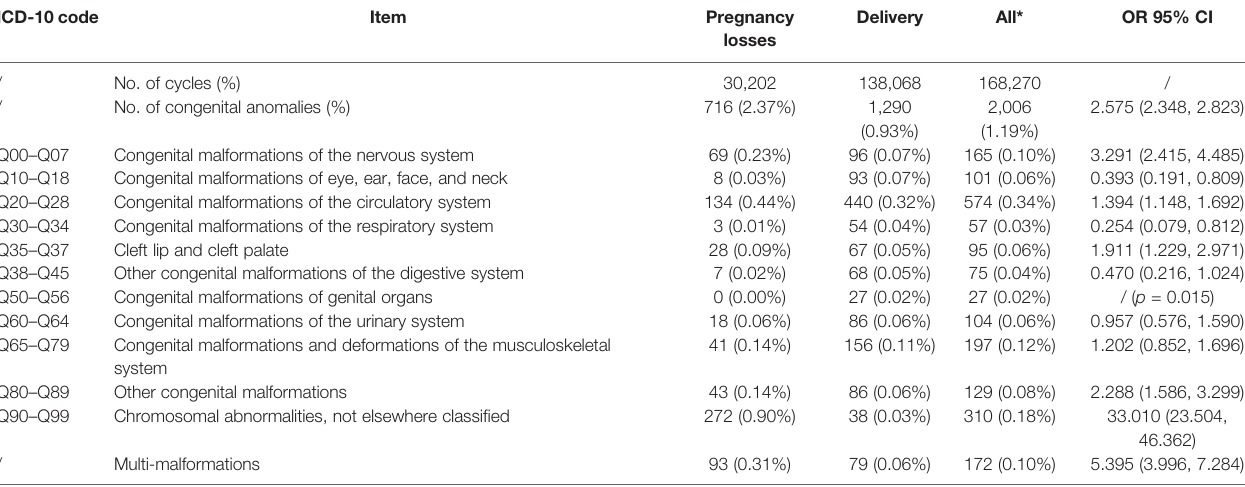
TABLE 1 | Congenital anomalies from in vitro fertilization